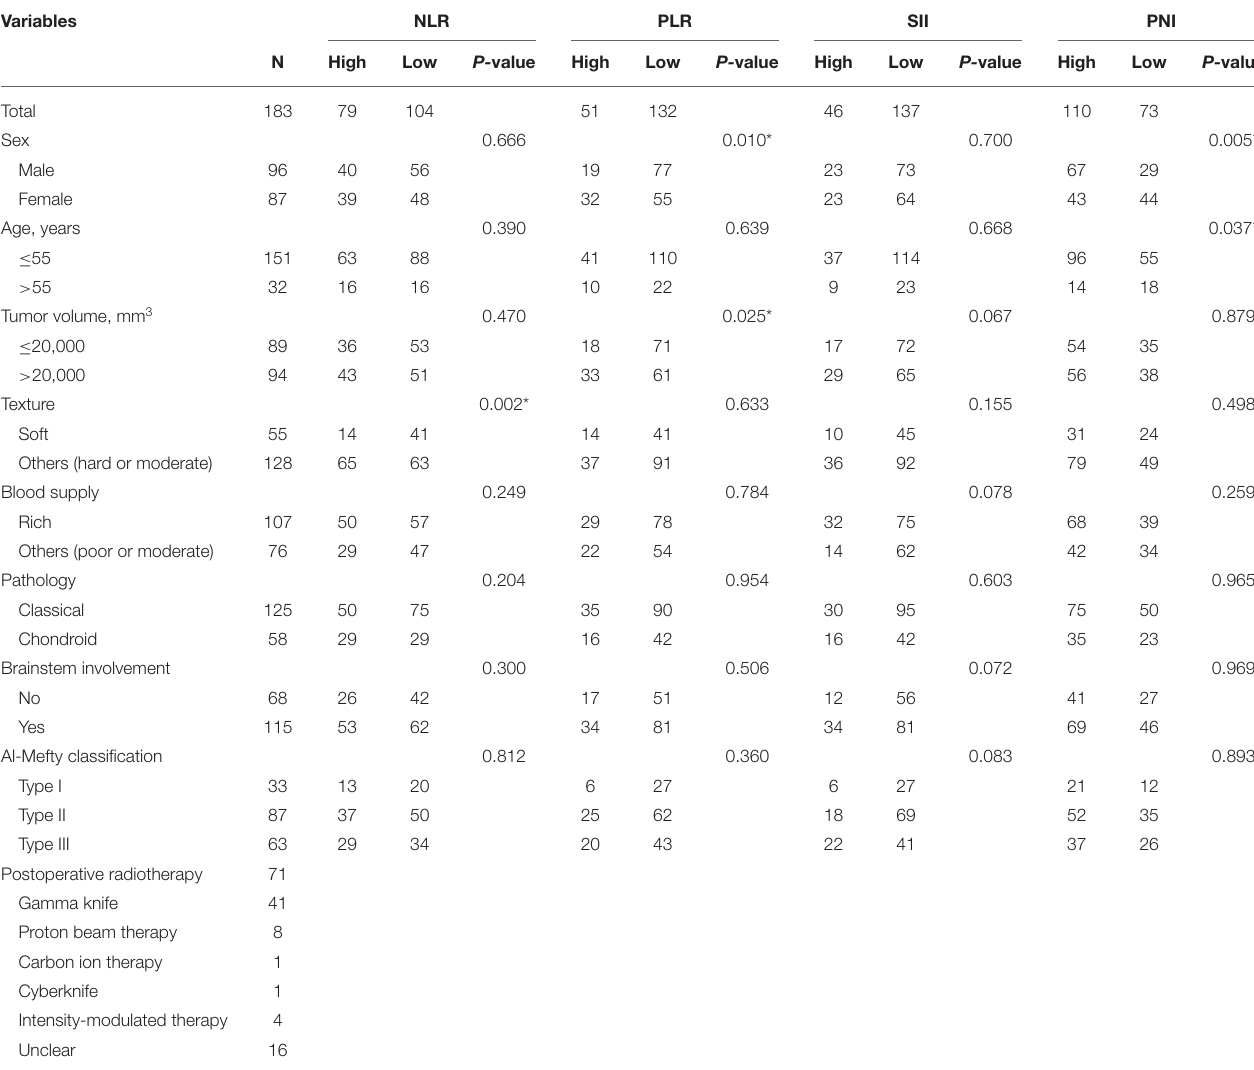
TABLE 1 | Association between the NLR, PLR, SII, PNI, and clinicopathological features of skull base chordoma patients.